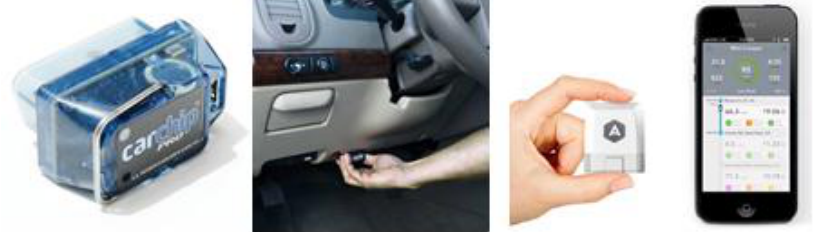
Figure 9. DIYdiagnostics: CarChip Connect and Automatic Link. Image credit: Davis Instruments [77] and Automatic